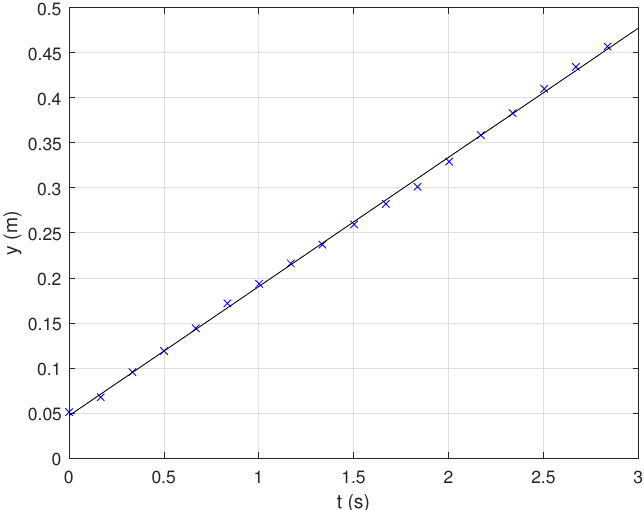
Figure 12. Measured position of sea star shown in Figure 11 as a function of time. The solid line is a linear fit. The coordinate system used is defined in Figure 2.